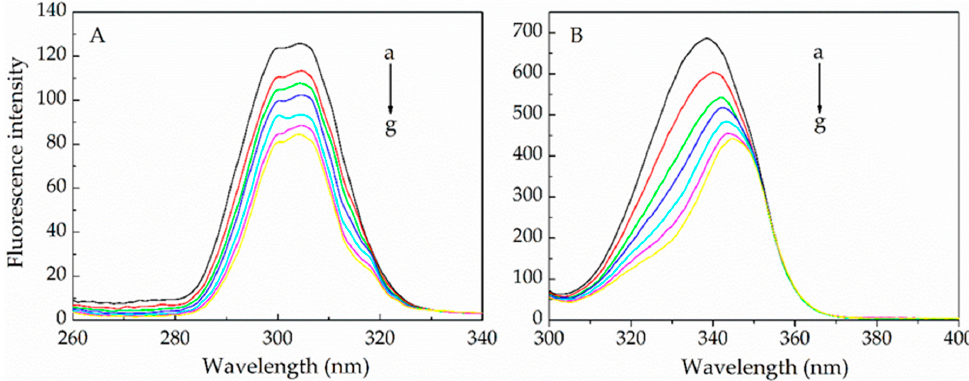
Figure 6. Synchronous fluorescence spectra of CAT with different concentrations of 2-MT. Conditions: ( A ) ∆ λ = 15 nm and ( B ) ∆ λ = 60 nm; CAT: 1.0 × 10 − 7 mol · L − 1 ; 2-MT: 0 mol · L − 1 (a); 1 × 10 − 5 mol · L − 1 (b); 2 × 10 − 5 mol · L − 1 (c); 3 × 10 − 5 mol · L − 1 (d); 4 × 10 − 5 mol · L − 1 (e); 5 × 10 − 5 mol · L − 1 (f); 6 × 10 − 5 mol · L − 1 (g); pH 7.4; T = 291